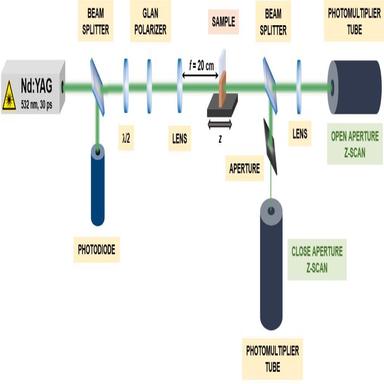
Open aperture and close aperture Z-scan technique.